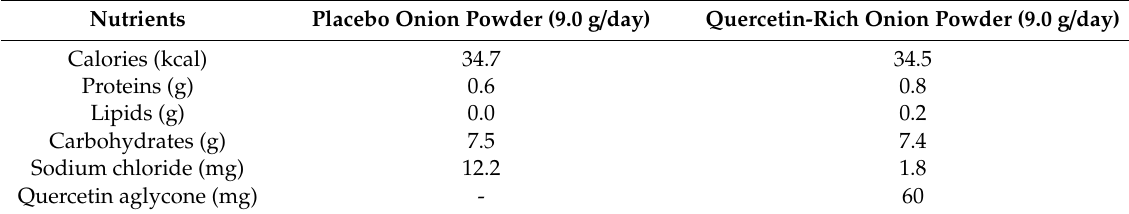
Table 3. Nutrients of test